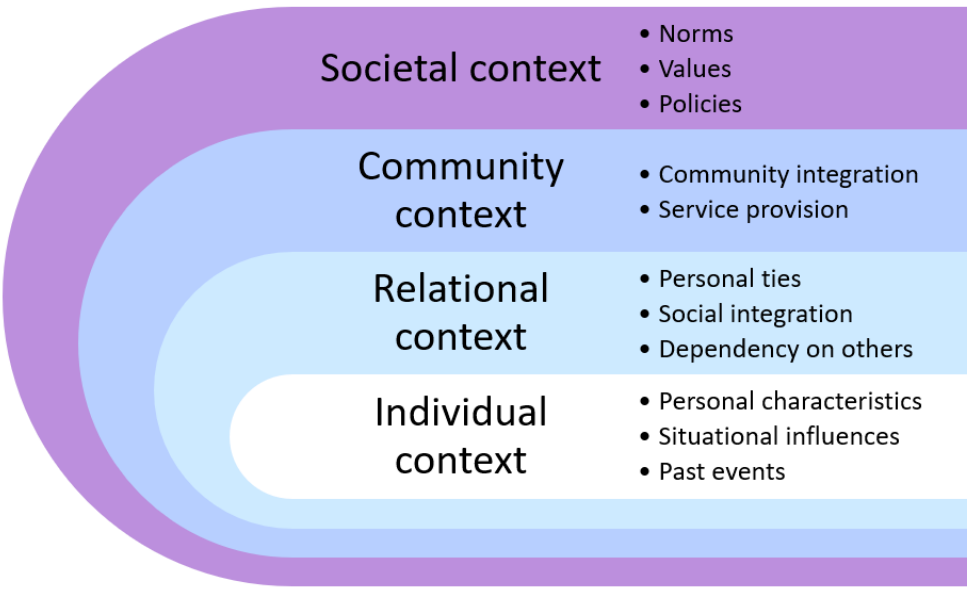
Figure 1. The contextual theory of elder abuse [7].